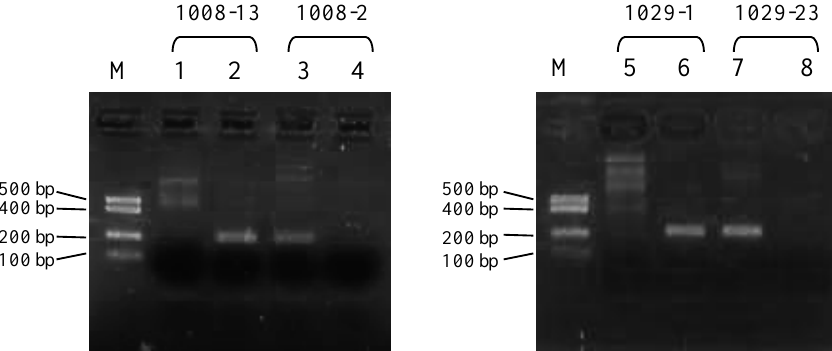
Figure 2. Typical patterns of 2% agarose gel electrophoresis of MAMA results. (A) MAMA results at the SNP site of AB703068: g.1008 C>T. MLNR-1008-13 and MLNR -1008-2 primer sets were used in lane 1 and 2, and in lane 3 and 4, respectively. Lane M, DNA size marker; lane 1 and 3, patterns of Haplotype 2; lane 2 and 4, patterns of Haplotype 1 and 3. (B) MAMA results at the SNP site